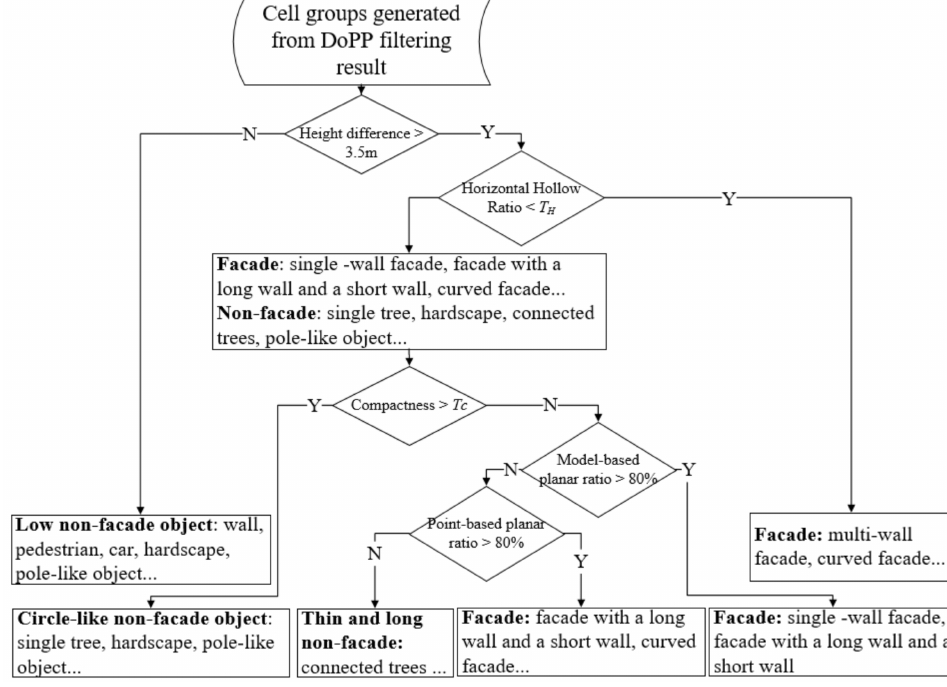
Figure 5. Facade optimization with the object-oriented decision tree.